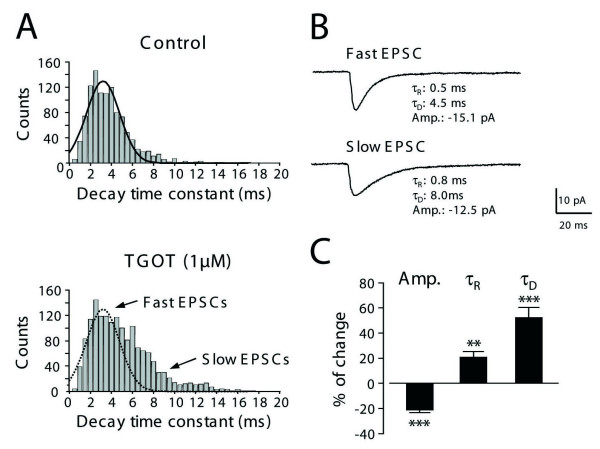
Application of TGOT reveals a population of AMPA-R miniature EPSCs with slow activation and deactivation kinetics. A: The histograms show the distribution of the decay time constants (τD) of miniature AMPA-R EPSCs pooled from 6 cells and detected during an identical time period of 5 minutes before (top, n = 1075 events) and after the application of 1 μM TGOT (bottom, n = 1563 events). In the presence of TGOT, the appearance of slowly decaying mEPSCs was noted in addition to the fast mEPSC population of mEPSCs with faster kinetics also found in the control situation. B: Averaged currents obtained from 91 individual mEPSCs of representative recorded neurons during TGOT treatment. Compared to the fast mEPSCs (upper trace), the averages of slow mEPSCs obtained in the presence of TGOT (lower trace) exhibited longer monoexponential constants for rise time (from τR = 0.5 ms in control to τR = 0.8 ms in TGOT) and decaying phases (from τD = 4.5 ms in control to τD= 8.0 ms in OT). The mean amplitude was also reduced in the presence of TGOT. C: Graph summarizing the changes observed in the mean amplitude (Amp.), rise time (τR), and decay time constants (τD) of AMPA-R mEPSCs during perfusion of TGOT. TGOT-induced increase in frequency was always associated with the appearance of slow rising and decaying currents having lower amplitudes. All changes observed during TGOT application were significant: p < 0.01 (**: τR, n = 6), and p < 0.001 (***: Amp and τD, n = 6) using the Student's t-test.